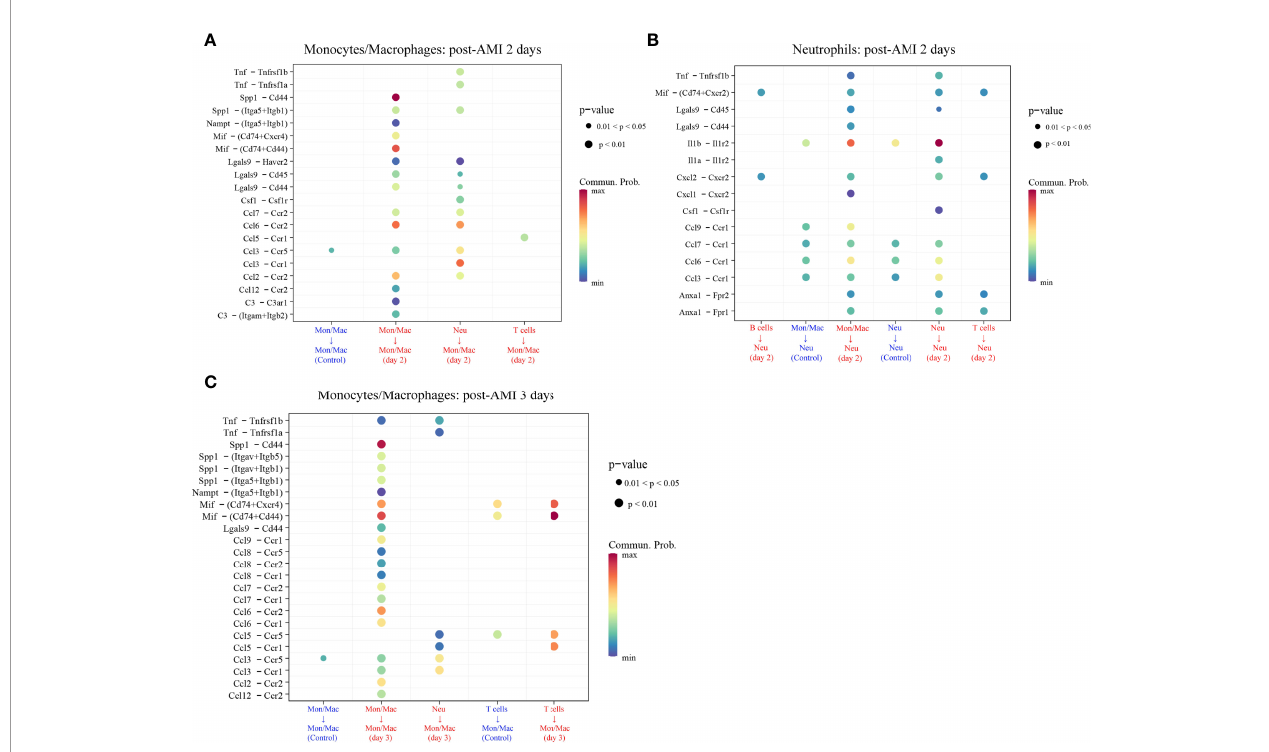
FIGURE 7 | Upregulated ligand – receptor signaling received by monocytes/macrophages (Mon/Mac) on days 2 (A) and 3 (C) after AMI and neutrophils (Neu) on days 2 after AMI (B) . Cell – cell communication of recipient Mon/Mac and Neu was analyzed by the “ CellChat ” package. Dot size re fl ects the P-value of the signaling. The scale color represents the level of communication probability from minimum to maximum. AMI, acute myocardial infarction; Neu,